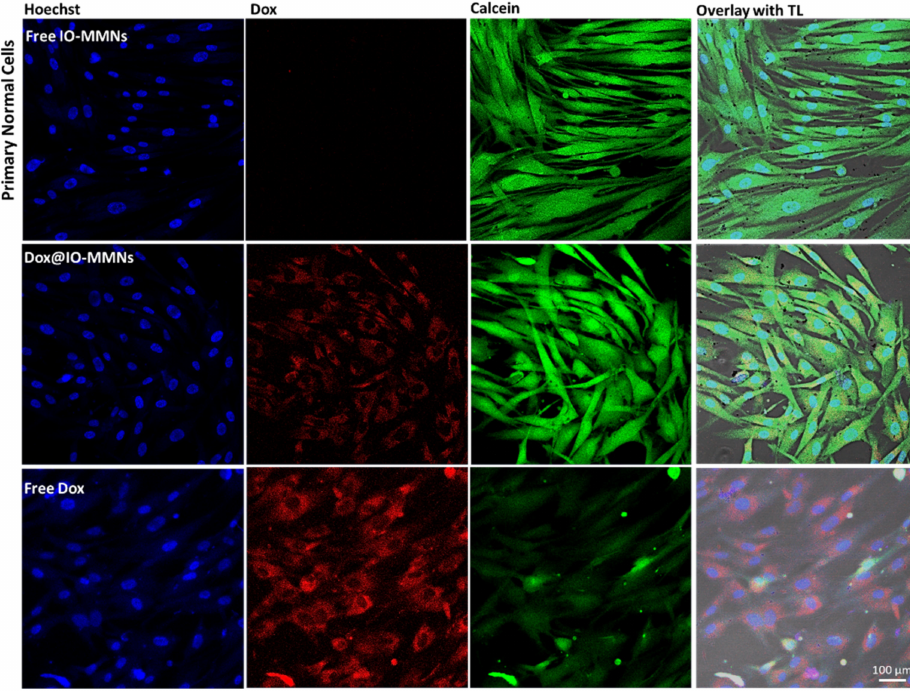
Figure 9. Live confocal microscopy images of primary normal cells after 24 h of incubation with free IO-MMNs, Dox@IO- MMNs, or free Dox (30 µ g/mL particles; 4 µ g/mL Dox). Left to right: Hoechst (blue) nuclei stain, Dox (red), Calcein (green) viable cells, and overlay of channels with transmitted light (TL). The confocal images noticeably show the viability of primary cells when incubated with both free IO-MMNs and Dox@IO-MMNs, but not with the free